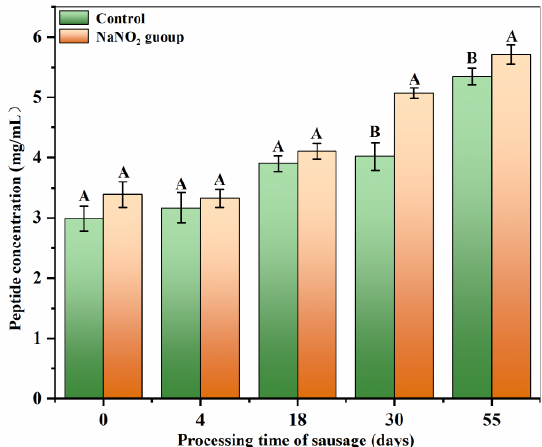
Figure 2. Changes in peptide concentration during sausage processing. Different uppercase letters in a column indicate significant differences among treatments during storage time (days) for each treatment ( p < 0.05).